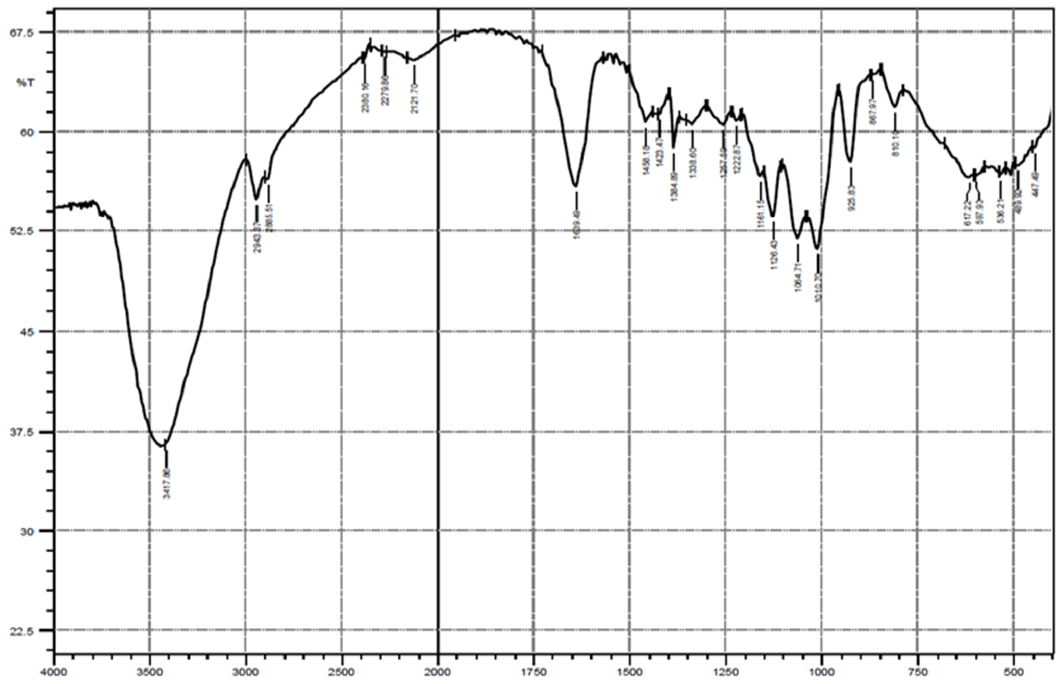
Figure 2. FTIR spectrum of Bacillus subtilis strain MZ292983.1.